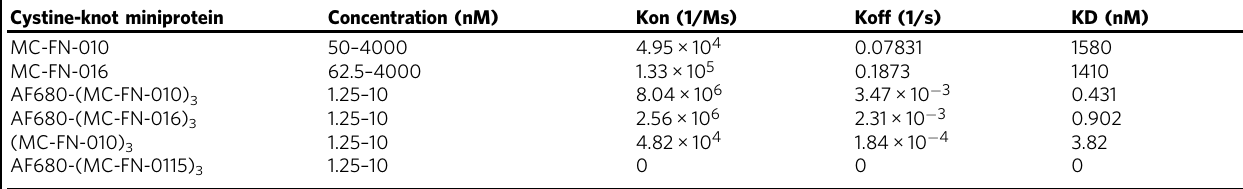
Table 1 SPR-binding analysis of cystine-knot miniprotein variants to EDB. Cystine-knot miniprotein